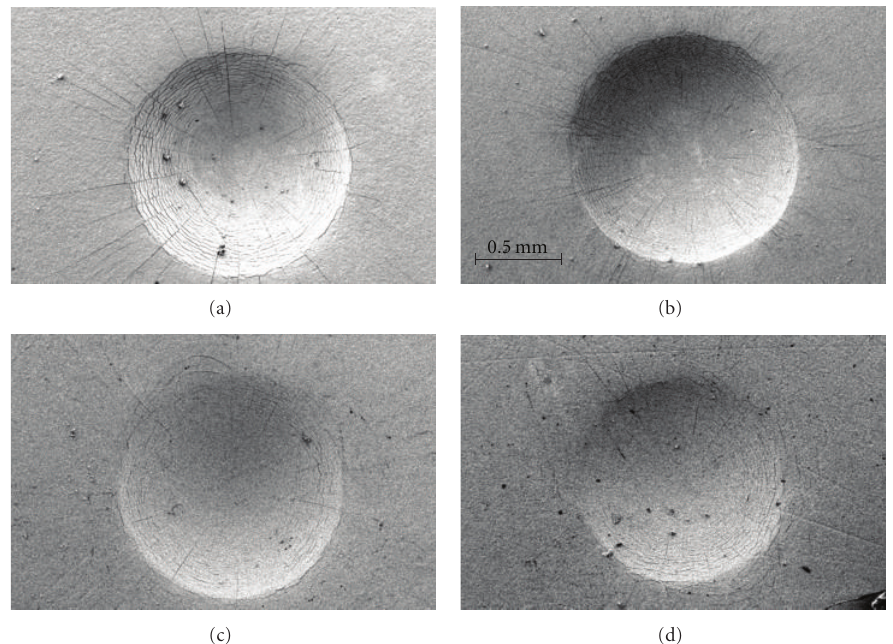
Figure 6: SEM observations of an indentation formed on pure Ni with an oxide film. (a) at 973 K, film thickness 16 μ m (at air 973 K), (b) at 973K, film thickness 7 μ m (at air 973K), (c) at R.T., film thickness 16 μ m (at air 973 K) and (d) at R.T. film thickness 7 μ m (water vapor at